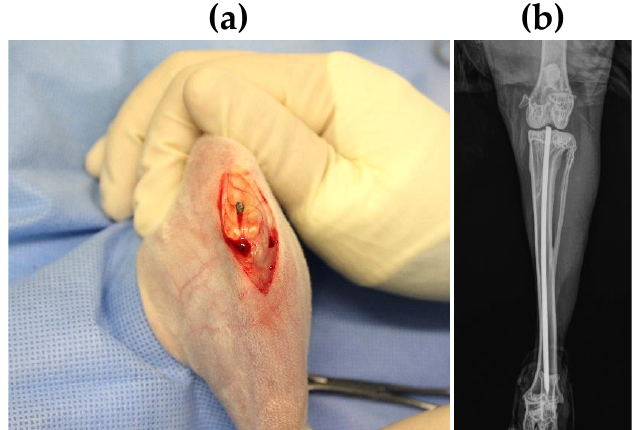
Figure 2. ( a ) Image of SML coated K-wire implanted in intramedullary canal, ( b ) Post-operative X-ray image of the rabbit tibia with the K-wire placement. Table 1. Main study-group setup.